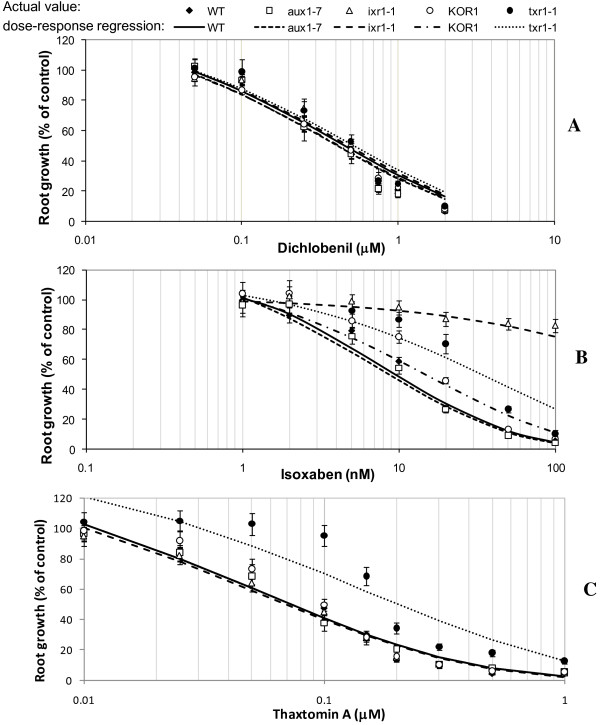
Root growth suppression of Arabidopsis lines in response to cellulose biosynthetic inhibitor treatment. Wild type and mutant Arabidopsis thaliana seedlings were treated for 72 h on medium containing (A) Dichlobenil; (B) Isoxaben, or (C) Thaxtomin A. Individual data points are expressed as mean percentages ± SE (n = 20) of control root growth on medium with no exogenous cellulose biosynthetic inhibitors applied.